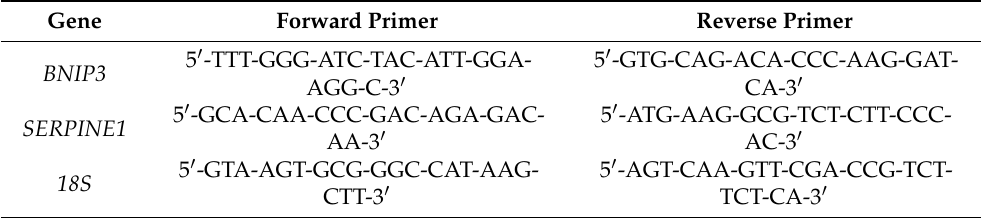
Table 2. Primers used for real-time polymerase chain reaction.